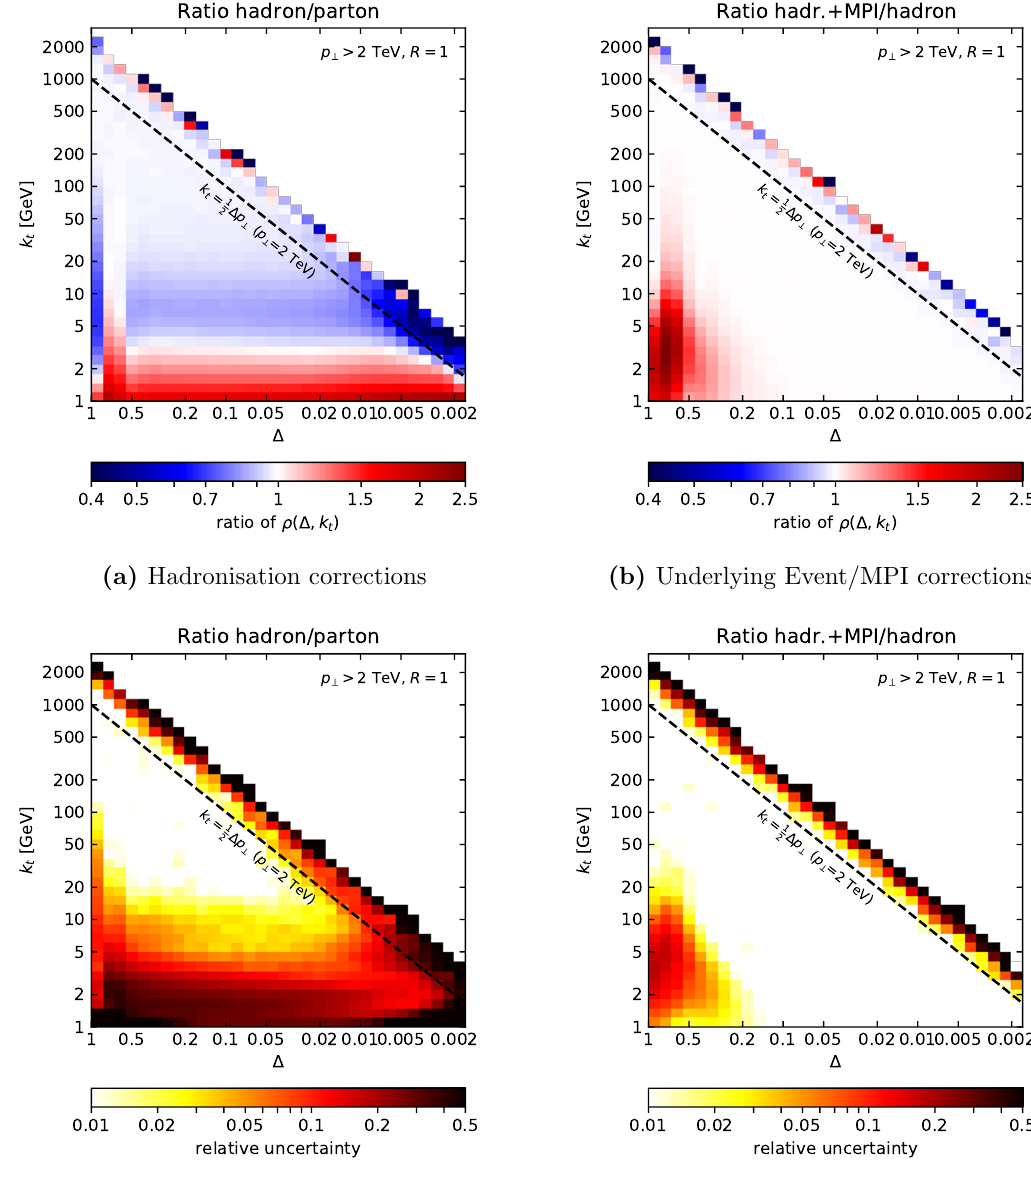
Figure 9. Non-perturbative corrections (top) and uncertainties (bottom). The diagonal dashed line corresponds to the kinematic limit, k t = 1